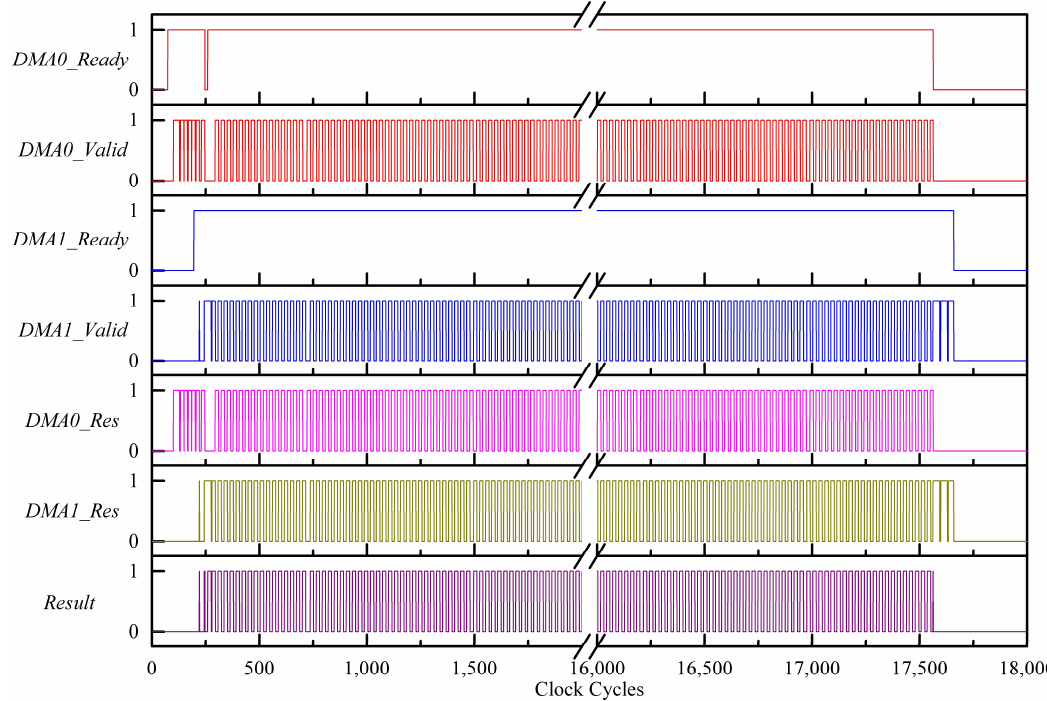
Figure 6. Transmission state diagram of DMA controller.